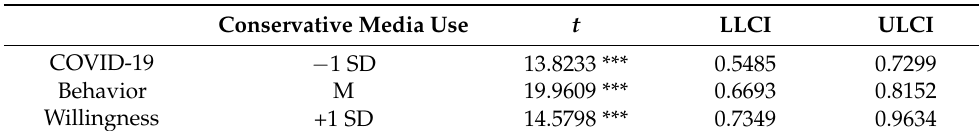
Table 2. Conditional Effects of Conservative Media Use and Media Literacy for Content on COVID-19 Behavioral Willingness.